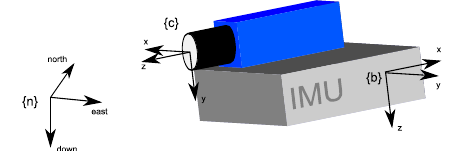
Figure 1: Overview of the coordinate systems used in this work